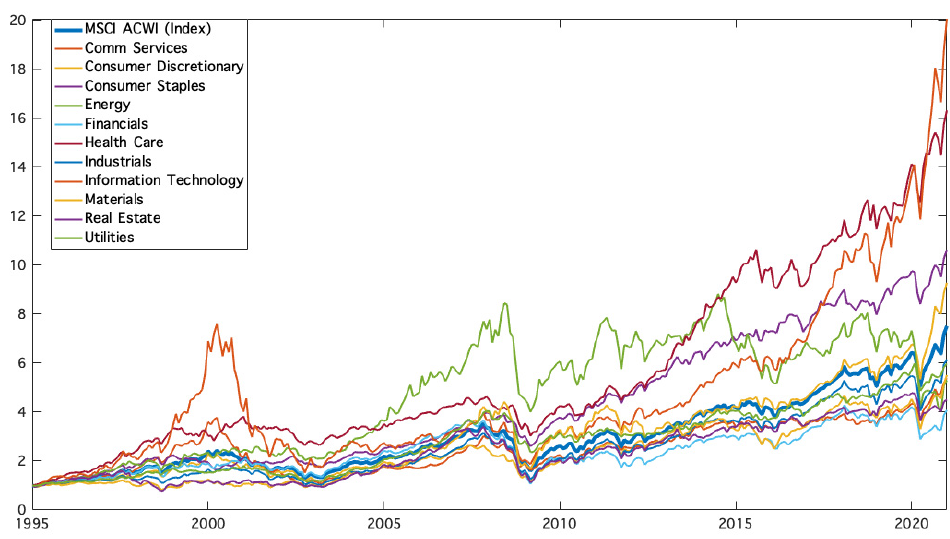
Figure 1. Cumulative returns of MSCI